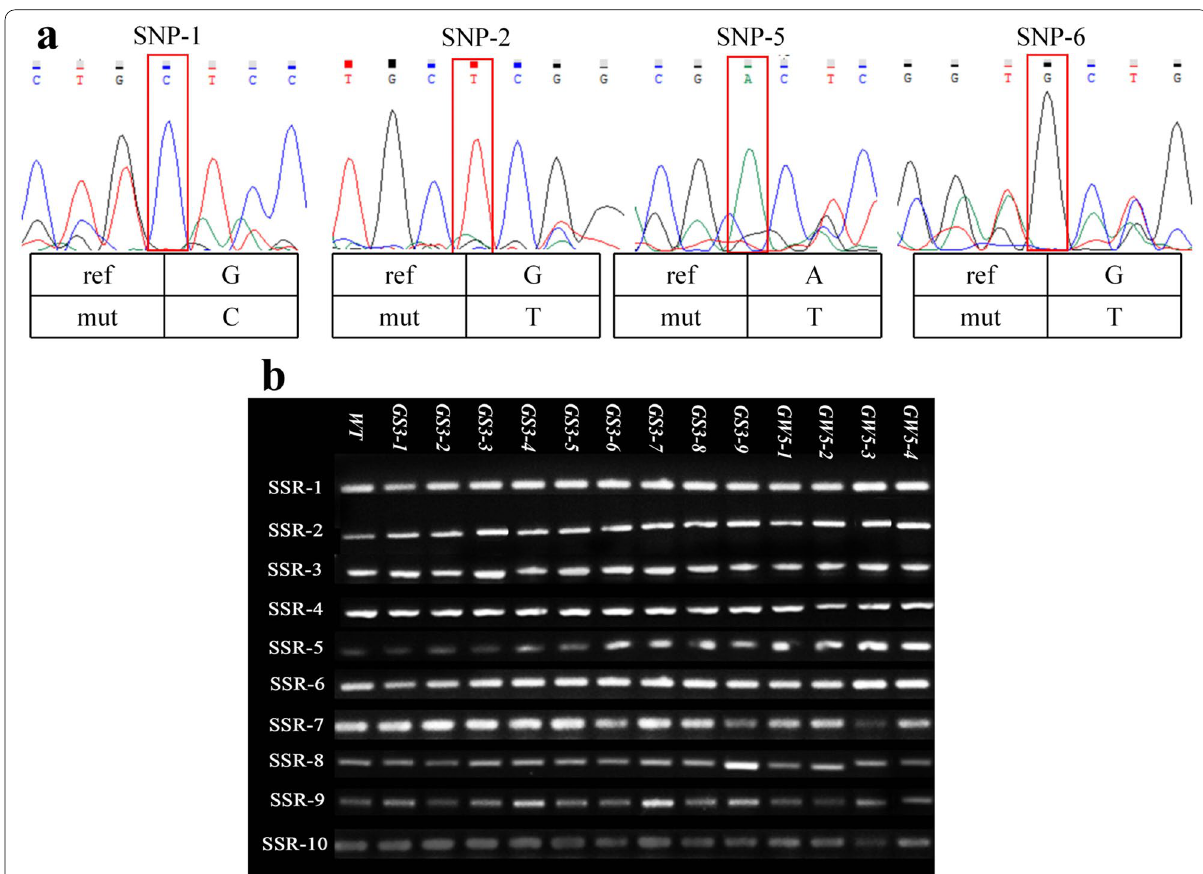
Fig. 4 a Sanger sequencing results; the red box is the target SNPs. The Sanger sequencing results of SNP-1 and SNP-2 were consistent with the targeted sequencing results. SNP-5 and SNP-6 were consistent with WT, and no variants were detected. b Results of agarose gel electrophoresis. The 10 SSR fragment polymorphisms of 13 mutant individual plants were consistent with WT